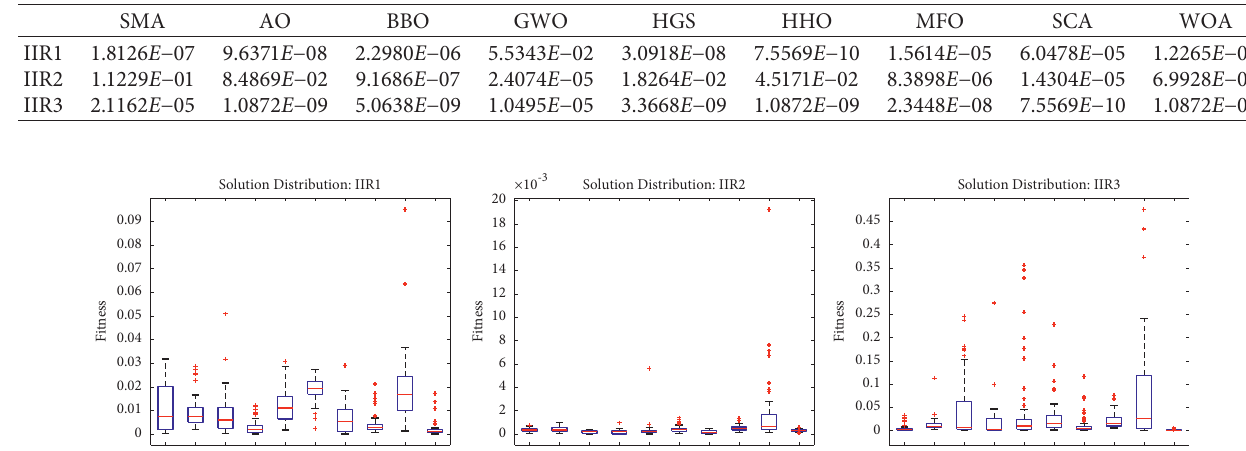
Table 8: p value of Wilcoxon test obtained on 3 IIR models.